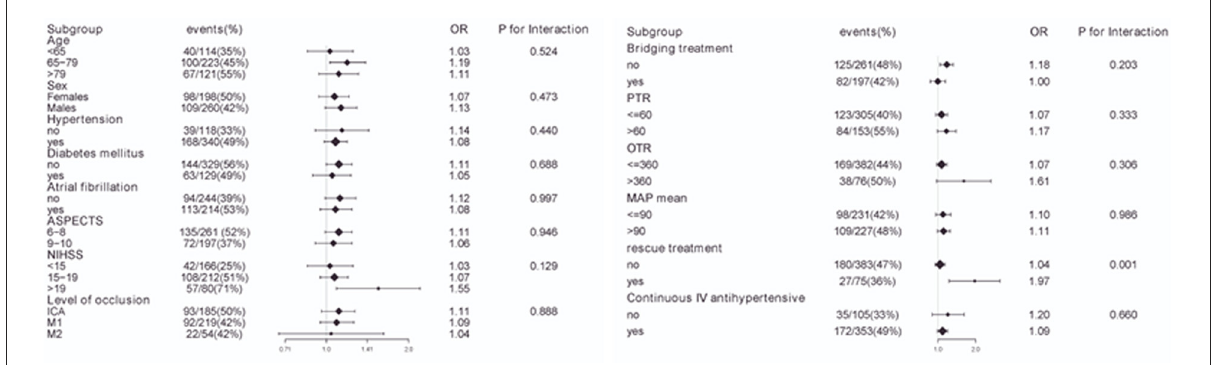
FIGURE5 Interaction test for the effect of MAP SD on futile recanalization in different subgroups after adjusting for confounding factors. The above model adjusted for confounding factors in Table 2 (Model II). In each case, the model is not adjusted for the stratification variable.